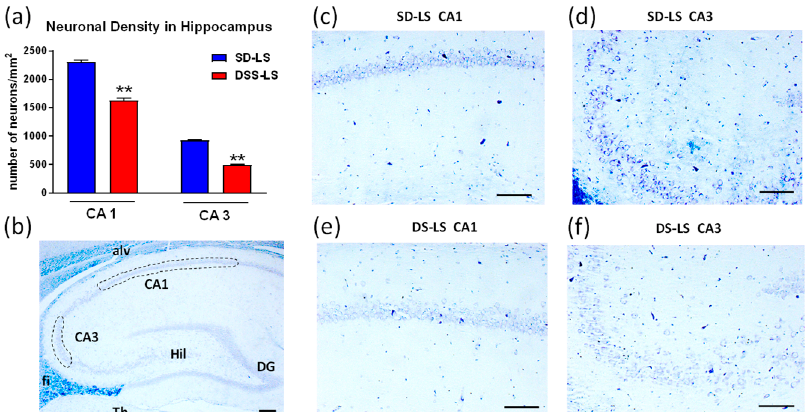
Figure 3. Neuronal density in the hippocampus of Sprague–Dawley (SD-LS) and Dahl salt-sensitive (DSS-LS) rats which were kept on a low-salt (LS) diet. ( a ) Neuronal density in CA1 and CA3 regions of hippocampus is presented as estimated number of neurons per mm 2 in a particular hippocampus region. Bars are presented as mean ± SEM; unpaired Student’s t -test: ** p < 0.01, DSS-LS rats ( n = 5) vs. SD-LS rats ( n = 5). ( b ) Representative image of a sagittal section of rat brain stained by Luxol/Cresyl violet stain; scale bar is 200 µm (right bottom corner). The quantified CA1 and CA3 regions which were used for the analysis of the neuronal density are schematically outlined by the dotted lines. Abbreviations for hippocampus and the surrounding regions: alv, alveus layer of CA; CA1 and CA3, Cornu Ammonis fields 1 and 3; DG, dentate gyrus; fi, fimbria; Hil, Hilus of DG; Th, thalamus. ( c – f ) Representative photomicrographs of CA fields stained by Luxol/Cresyl violet stain. Neurons are stained dark blue to purple. Scale bars, 50 µm (right bottom corner). ( c ) SD-LS CA1 area; ( d ) SD-LS CA3 area; ( e ) DSS-LS CA1 area, ( f ) DSS-LS CA3 area.